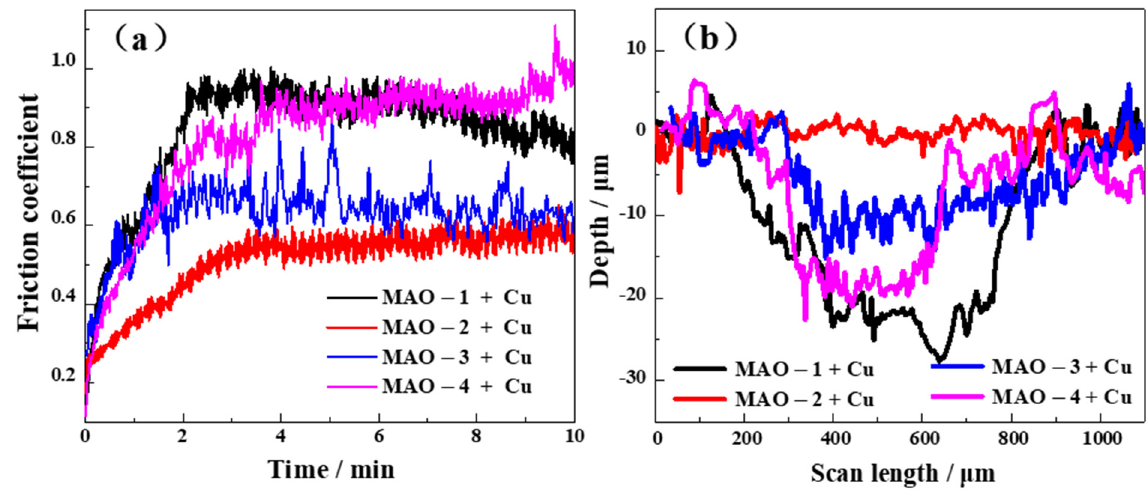
Figure 3. Binding strength of composite coatings: ( a ) MAO-1+ Cu; ( b ) MAO-2 + Cu; ( c ) MAO-3 + Cu; ( d ) MAO-4 + Cu.